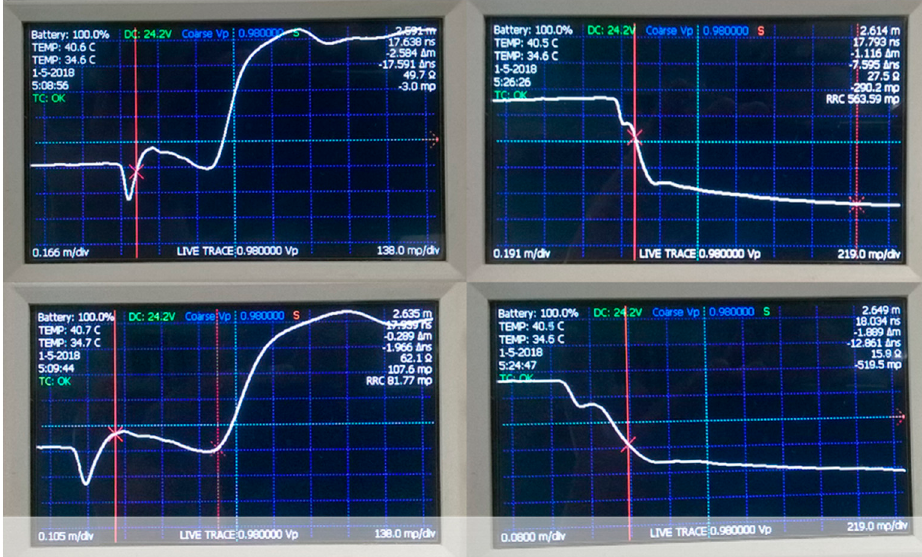
are given in Table 3. TDR-estimated VSMC values using all three models tested could not be obtained, with rates of more than 15% for BC G , and therefore are not reported in Table 2.